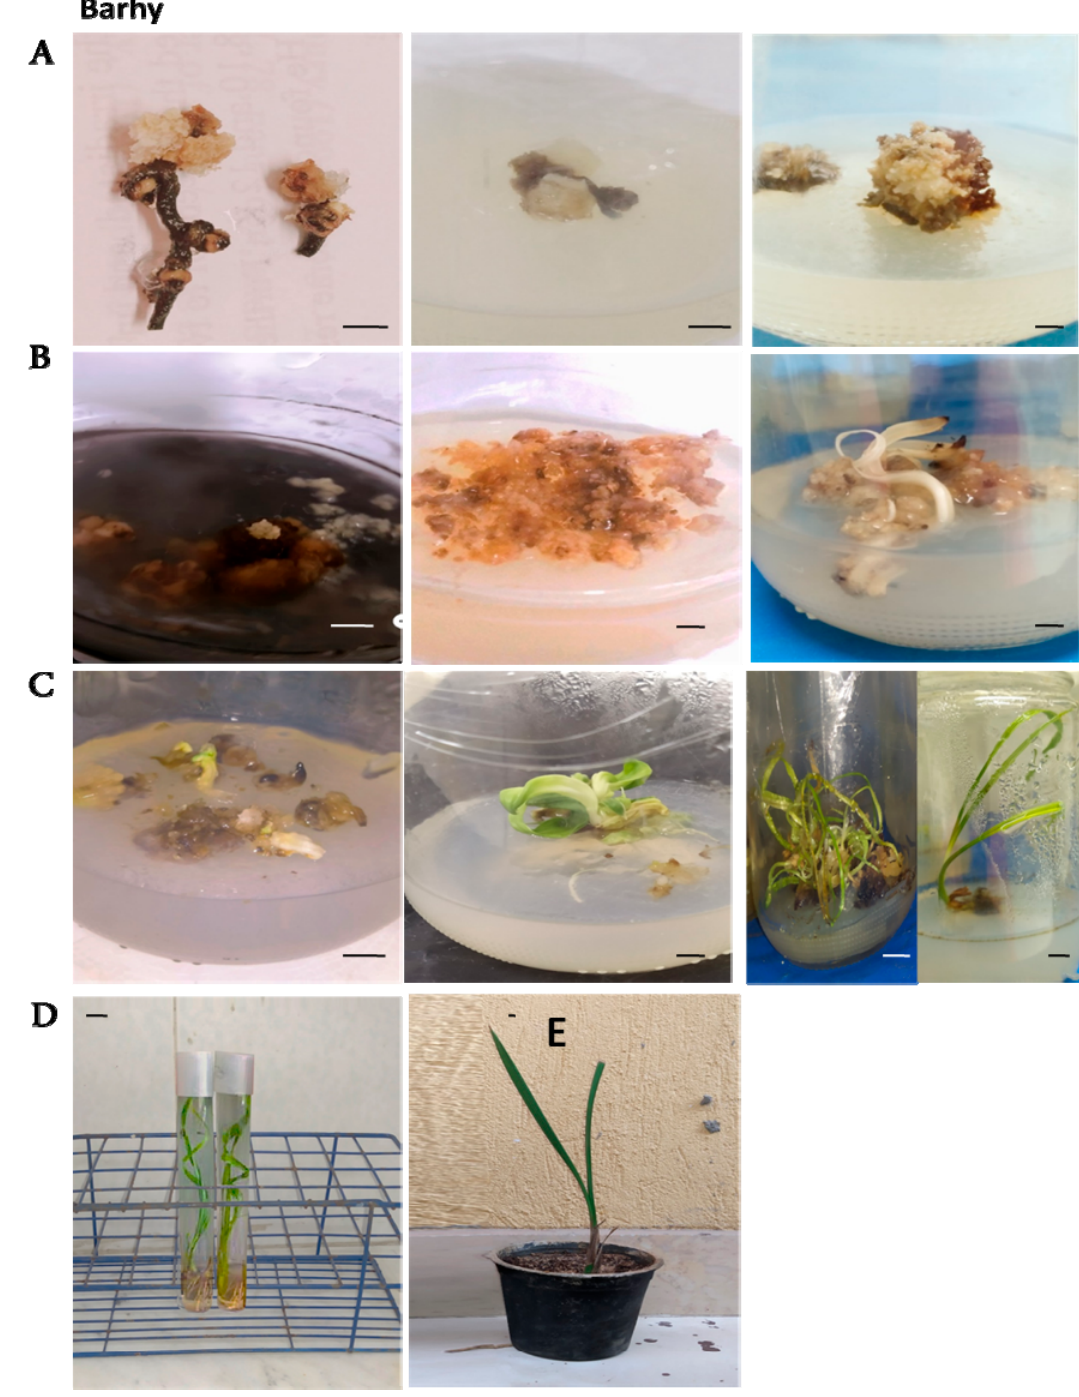
Figure 4. Date palm micropropagation by immature female inflorescences in Barhy variety. ( A ). Various structures of callus formation and development on starting media after the first subculture, the second subculture and the third subculture, respectively (from left to right). ( B ). Matured embryogenic calli and development of somatic embryogenesis under darkness after 8 weeks, 12 weeks and 16 weeks, respectively (from left to right). ( C ). Germinated somatic embryos and shoot multiplication after 4 weeks, 6 weeks and 12 weeks, respectively (from left to right). ( D ). Shoot rooting. ( E ). Acclimatized plantlets. Scale bar: 1 cm.